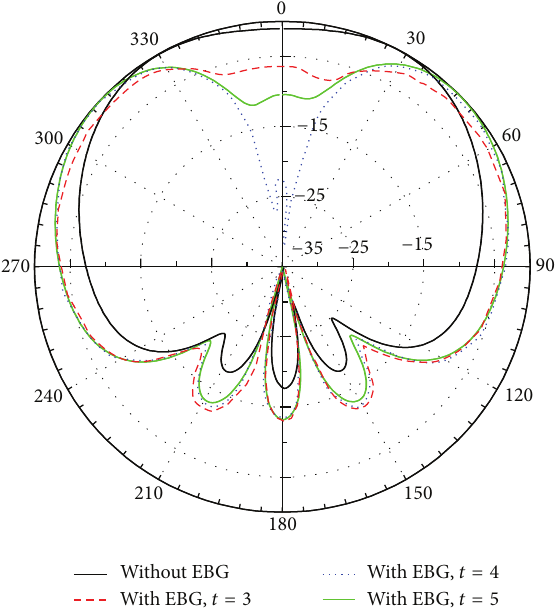
Figure 3: Simulated radiation patterns of switchable surface wave antenna (when t = 3, 4, 5mm and without EBG).